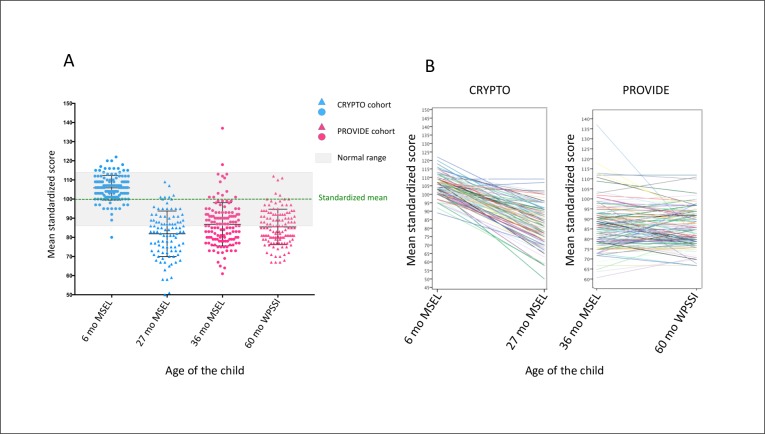
Child developmental outcomes.(A) Overview of children’s standardized performance. (B) Spaghetti plots of changes in children’s performance across the two time points in each cohort. Note change in the developmental outcome measure from MSEL at 36 to WPPSI at 60 months.